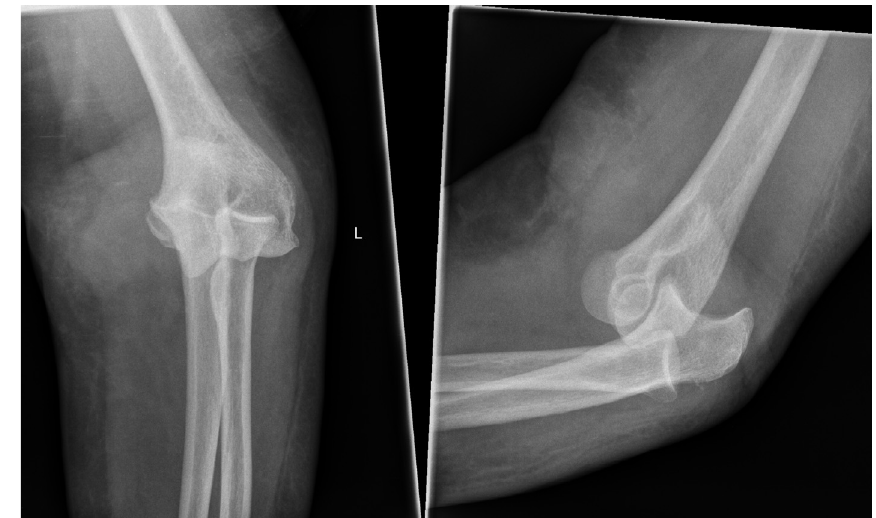
Figure 3. Elbow AP and lateral radiographs three weeks post injury showing dislocation.